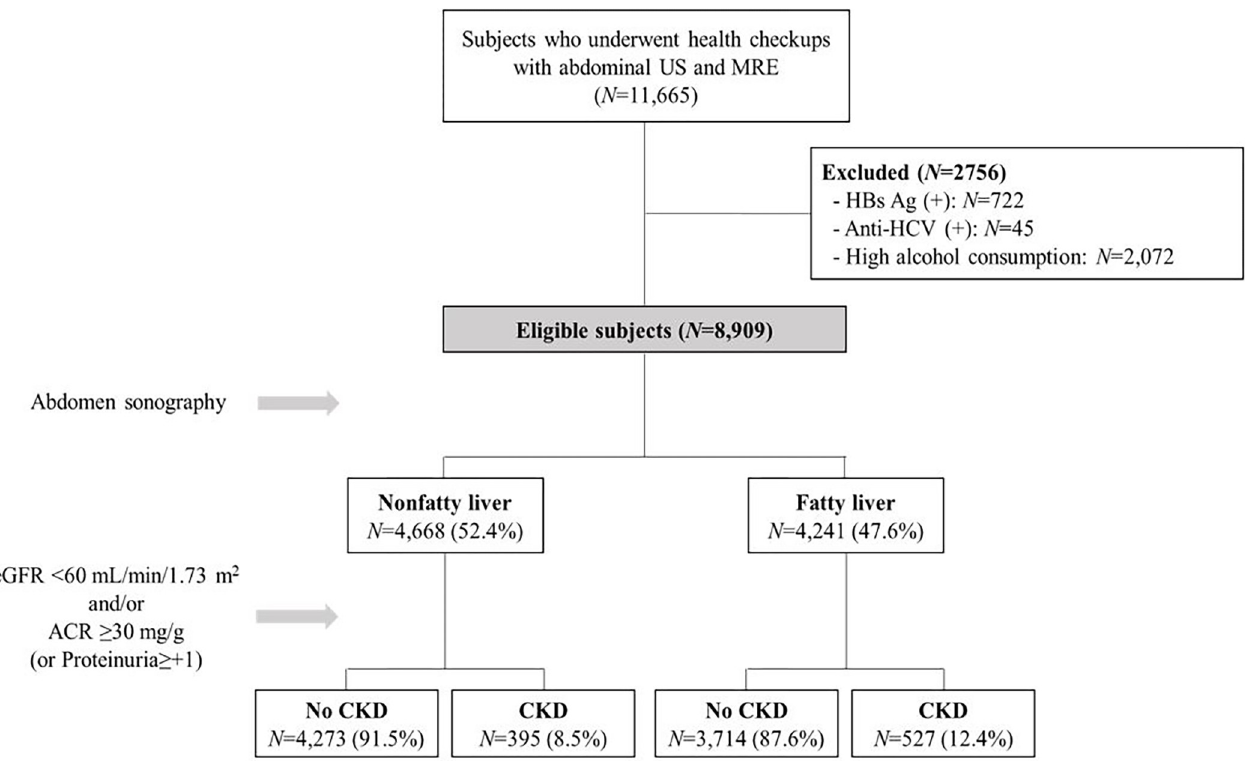
Fig 1. Flow chart of the